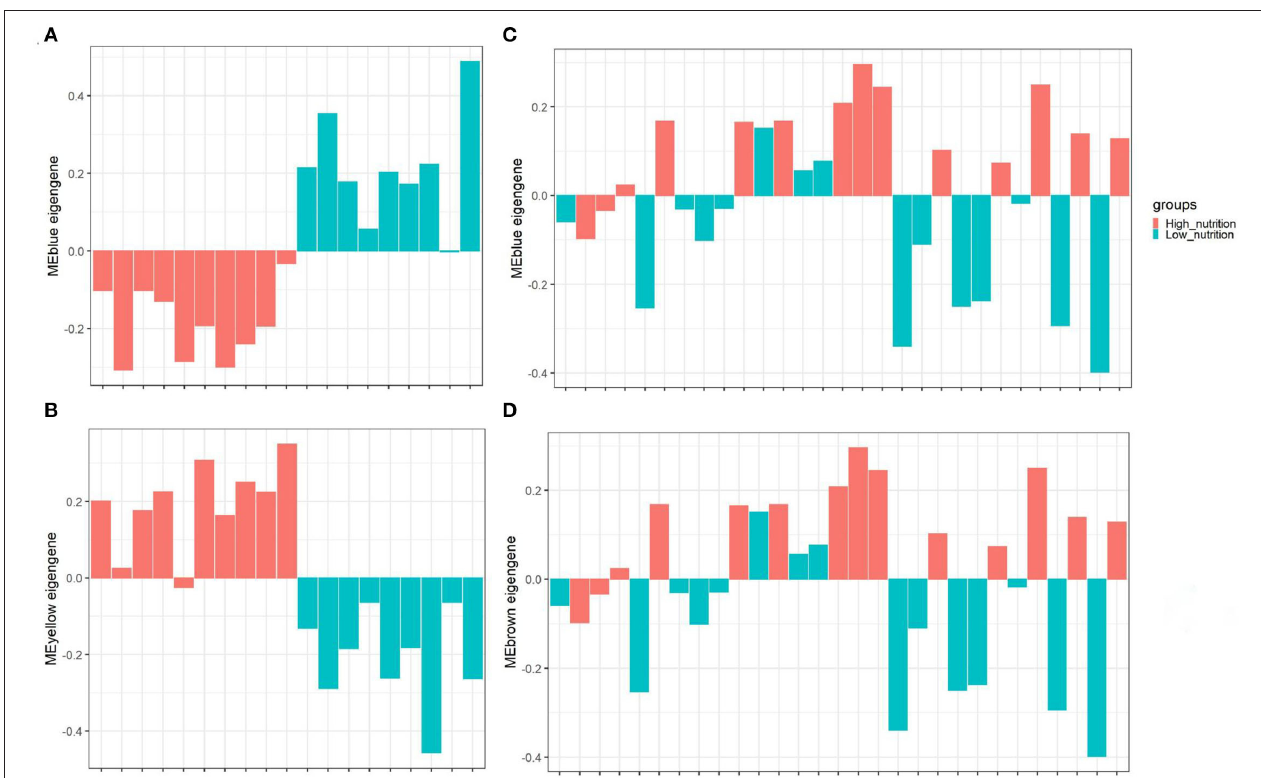
FIGURE 3 | The distribution of MEs among different groups of samples. The blue module (A) and yellow module (B) identified in subcutaneous adipose tissue (PRJNA382633). The blue module (C) and brown module (D) identified in visceral adipose tissue (PRJNA664093). The horizontal axis represents the sample, and the vertical axis represents the ME value. The color represents the group of samples indicated in the upper right